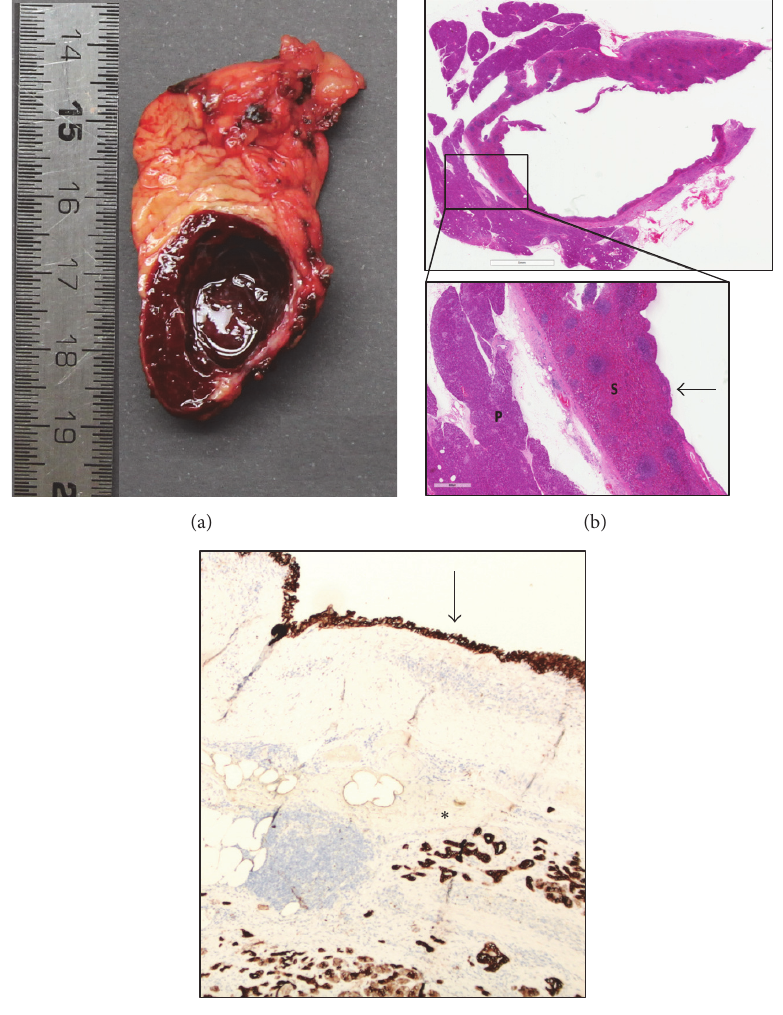
Figure 4: (a) Photograph of the cut gross specimen showing well-defined splenic tissue with a unilocular cyst. (b) Hematoxylin-eosin staining showing pancreatic parenchyma (P) and adjacent splenic parenchyma (S) and the cyst wall lined by multilayered epithelium without atypia (arrow). (c) Cytokeratin 5 staining showing positivity in the cyst lining (arrow) and in surrounding pancreatic parenchyma (asterisk) indicating epithelial